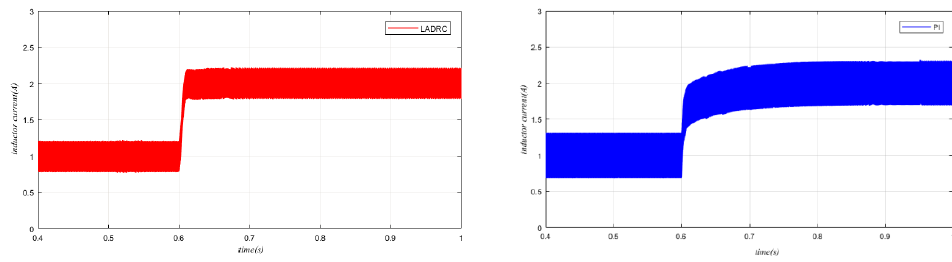
Figure 13. Inductance current responses in Case 3.